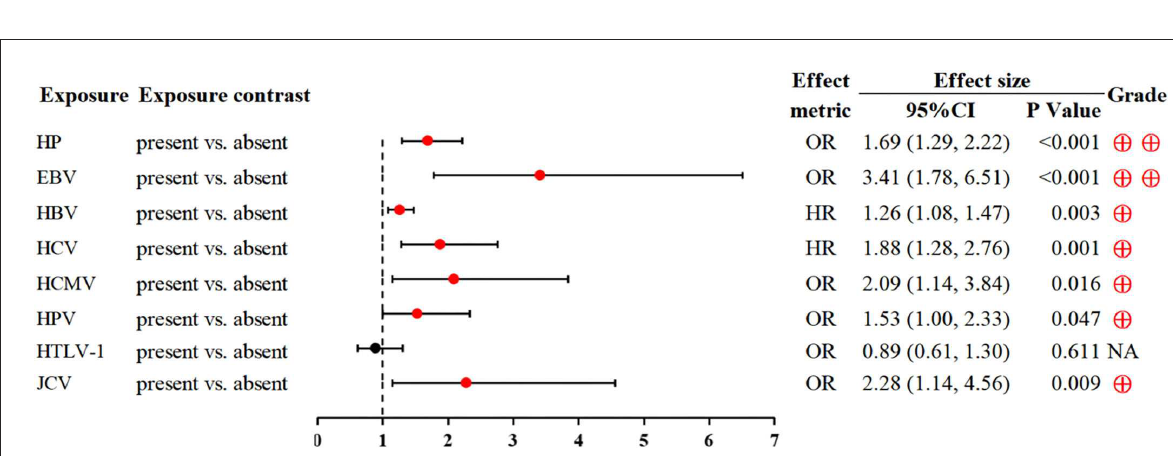
FIGURE8 Forest plot: summary effect estimates of meta-analyses reporting associations between GC and factors pertaining to viral or bacterial infection. HP, Helicobacter pylori; EBV, Epstein-Barr virus; HBV, hepatitis B virus; HCV, hepatitis C virus; HCMV, human cytomegalovirus; HPV, human